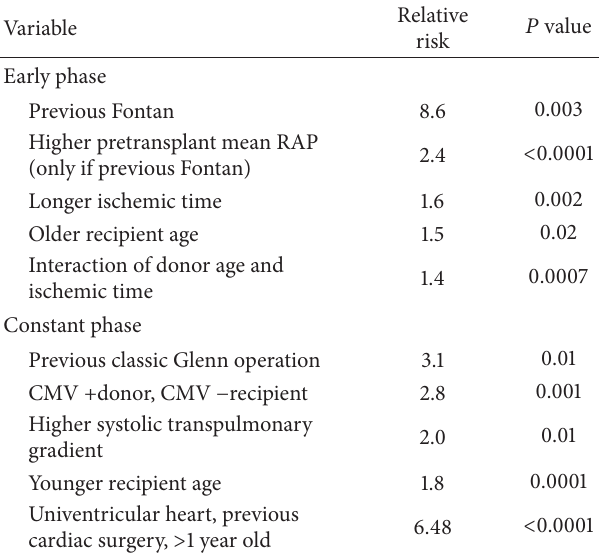
Table 4: Risk factors for heart transplantation according to Lamour et al. 2009